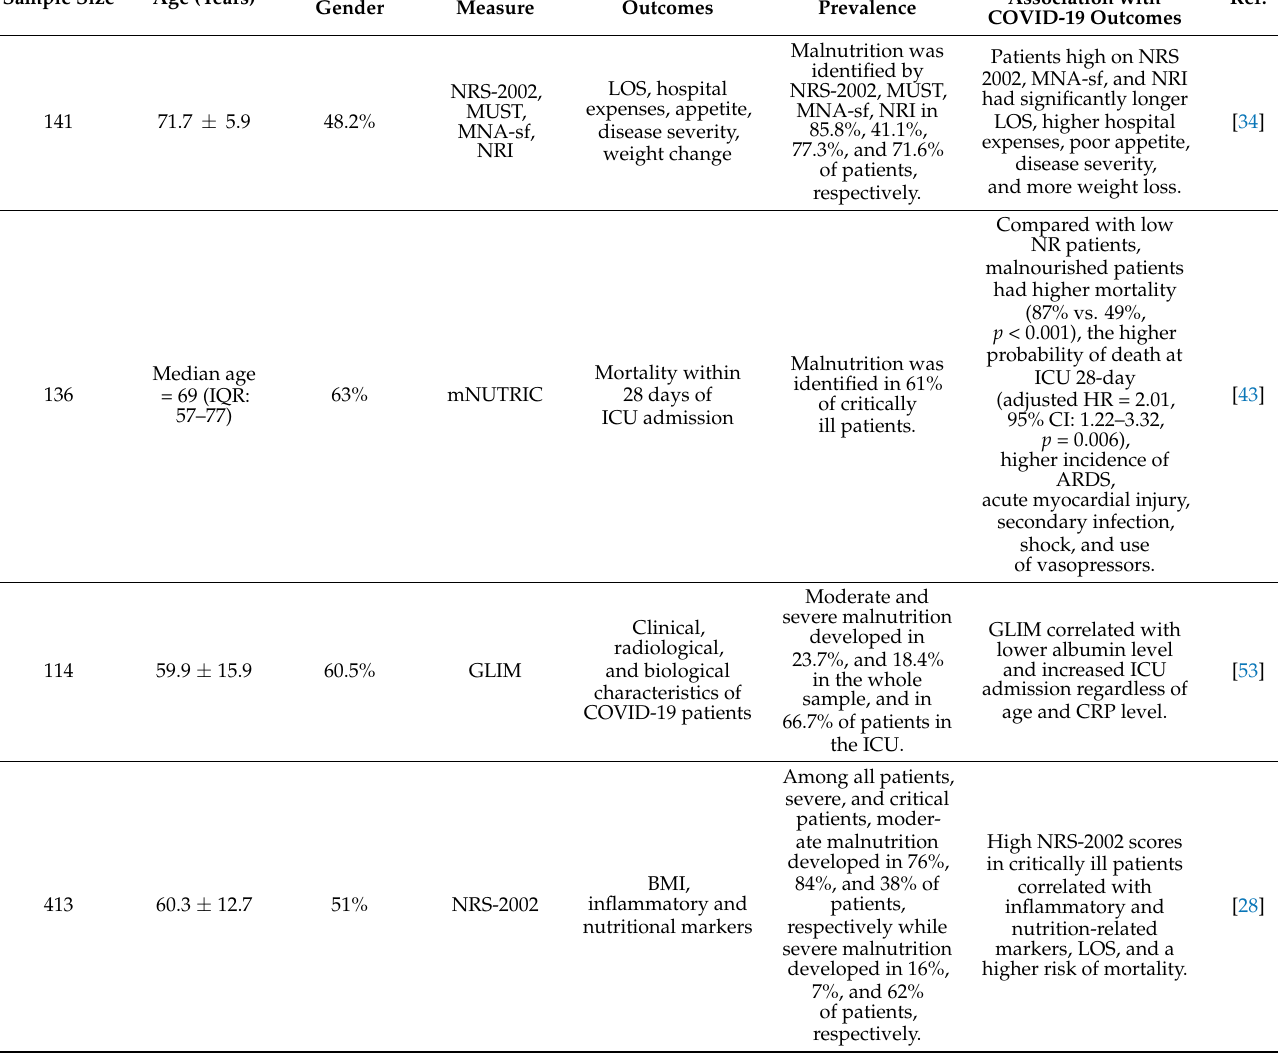
Table 1. Nutritional assessment measures in COVID-19 and their correlation with disease severity and prognosis. Sample